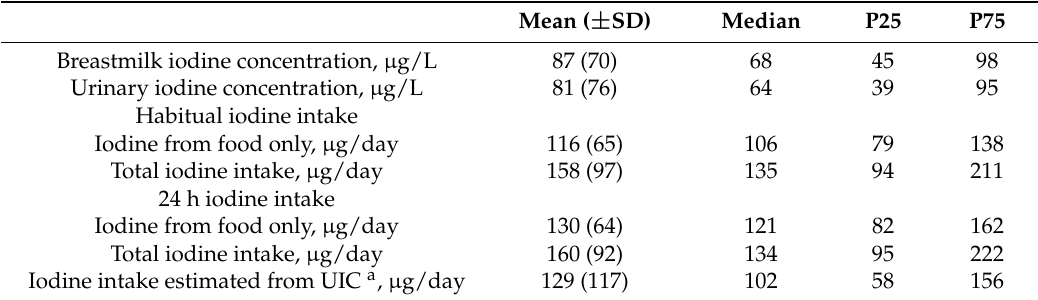
Table 3. Breastmilk iodine concentration, urinary iodine concentration, habitual iodine intake from food and supplements, and 24 h iodine intake from food and supplements in a group of lactating women in Norway ( n = 175).